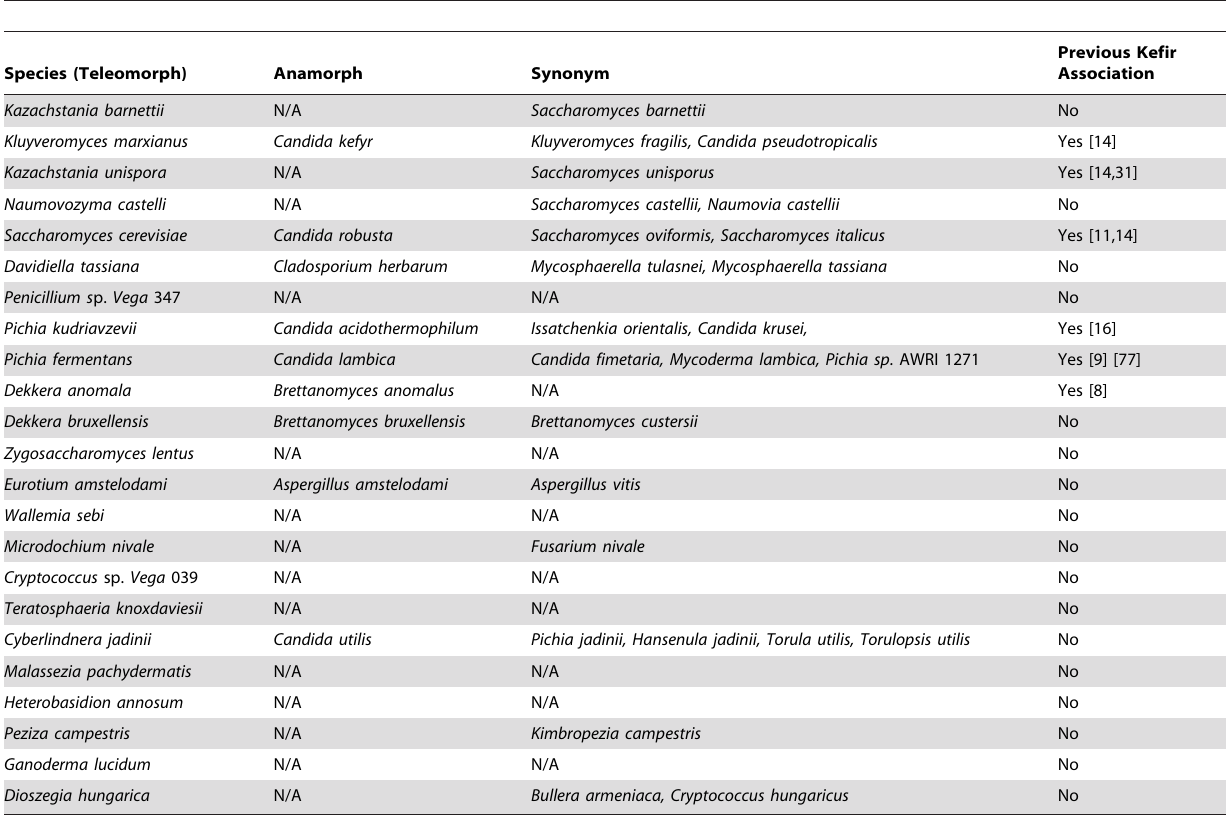
Table 1. List of fungal species identified in the study, listed in teleomorph form with anamorph or synonym names and previous kefir